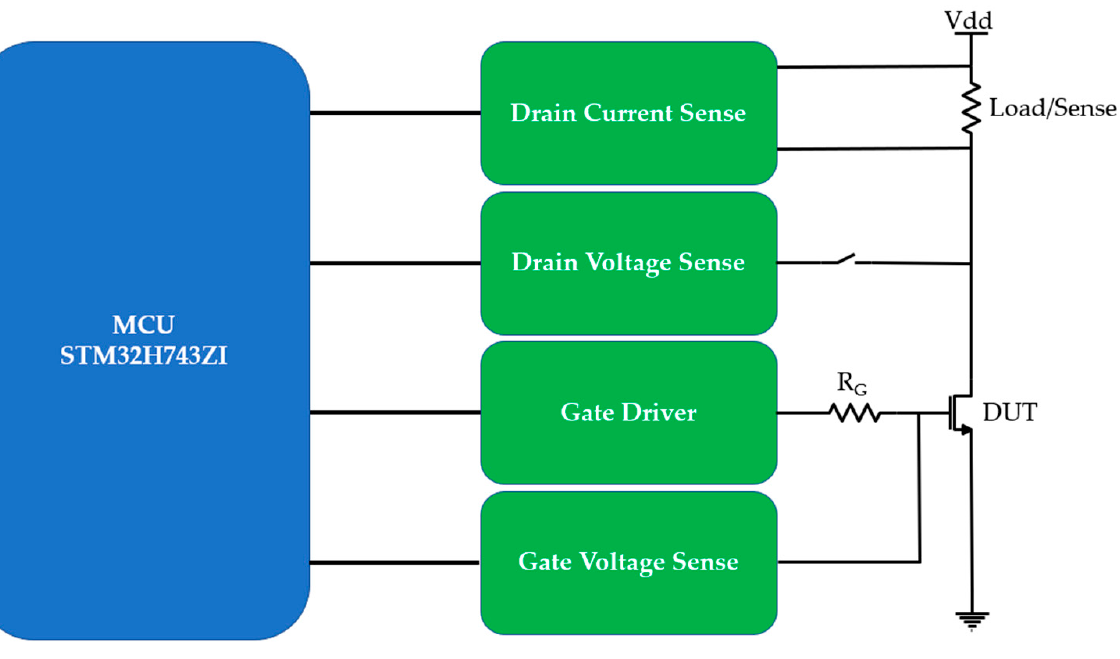
Figure 3. Measurement system block diagram.